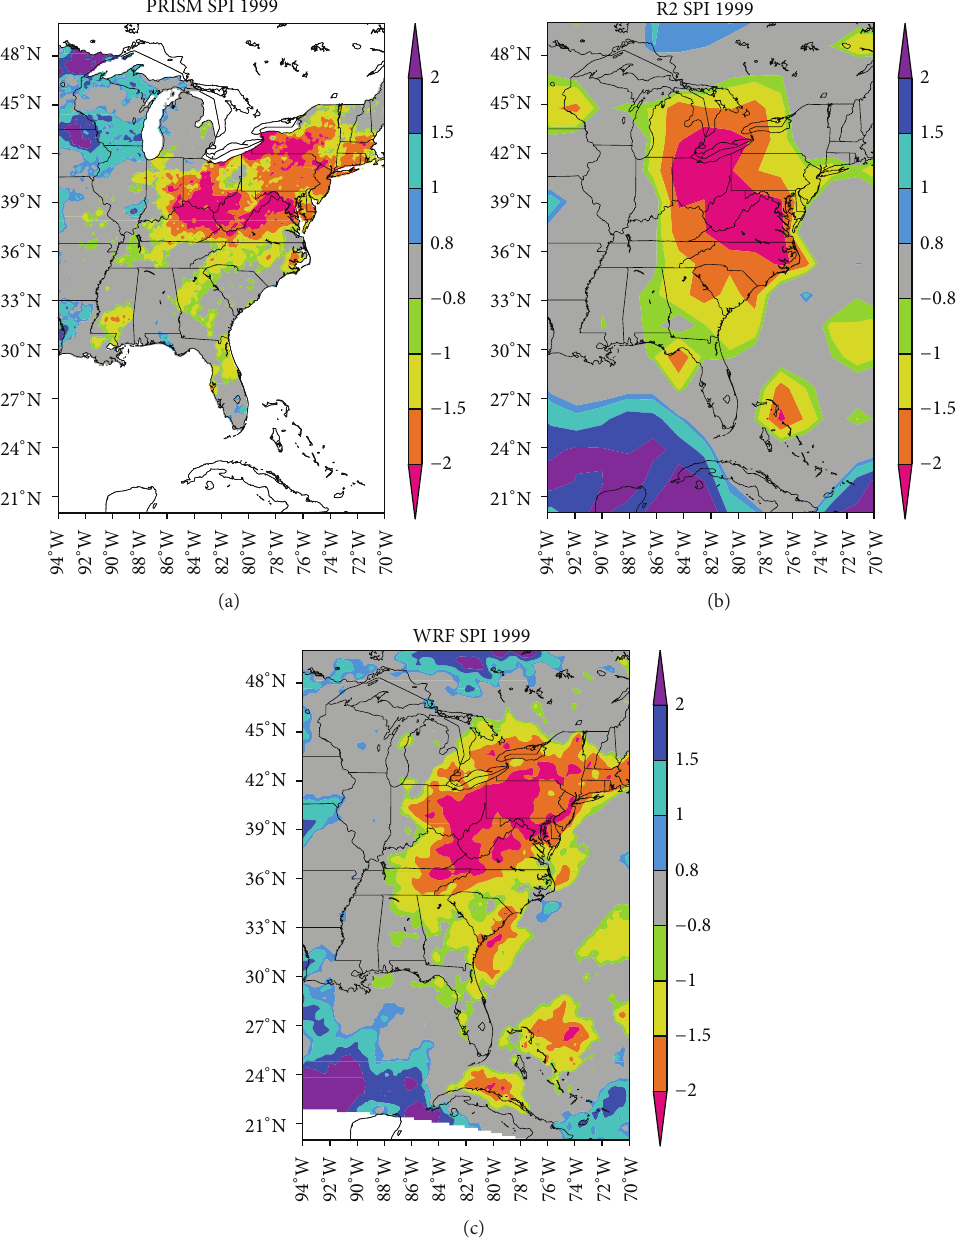
Figure 9: 12-month SPI for the period ending in July 1999 calculated from (a) PRISM, (b) R2, and (c) WRF.